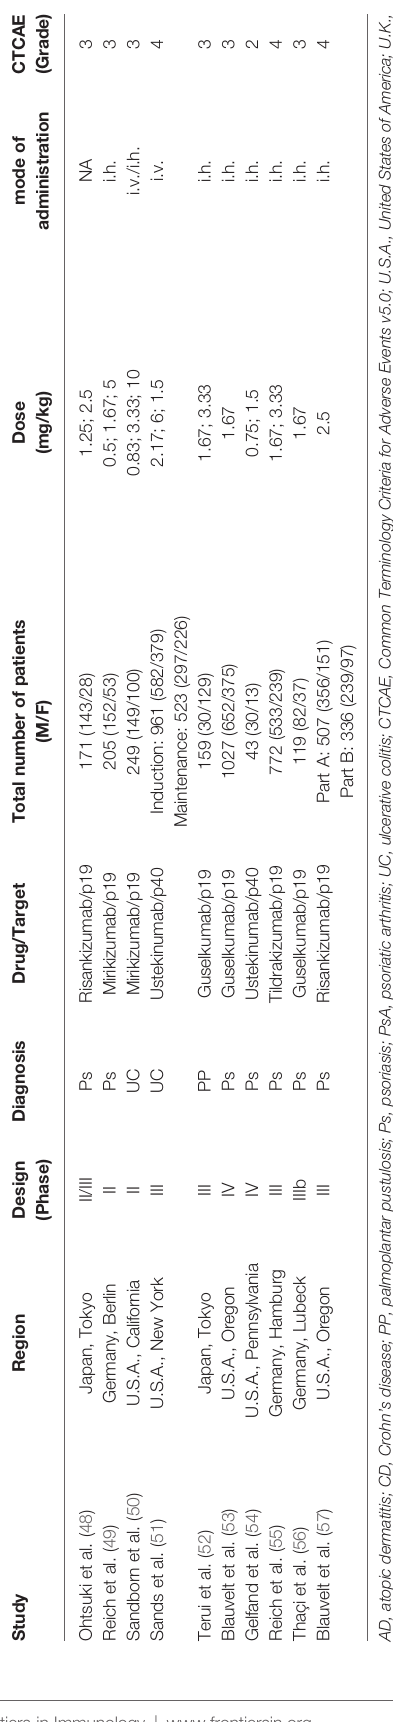
Meta-regression Number Meta-regression P -value for of coef fi cient with studies 95% con fi dence interval